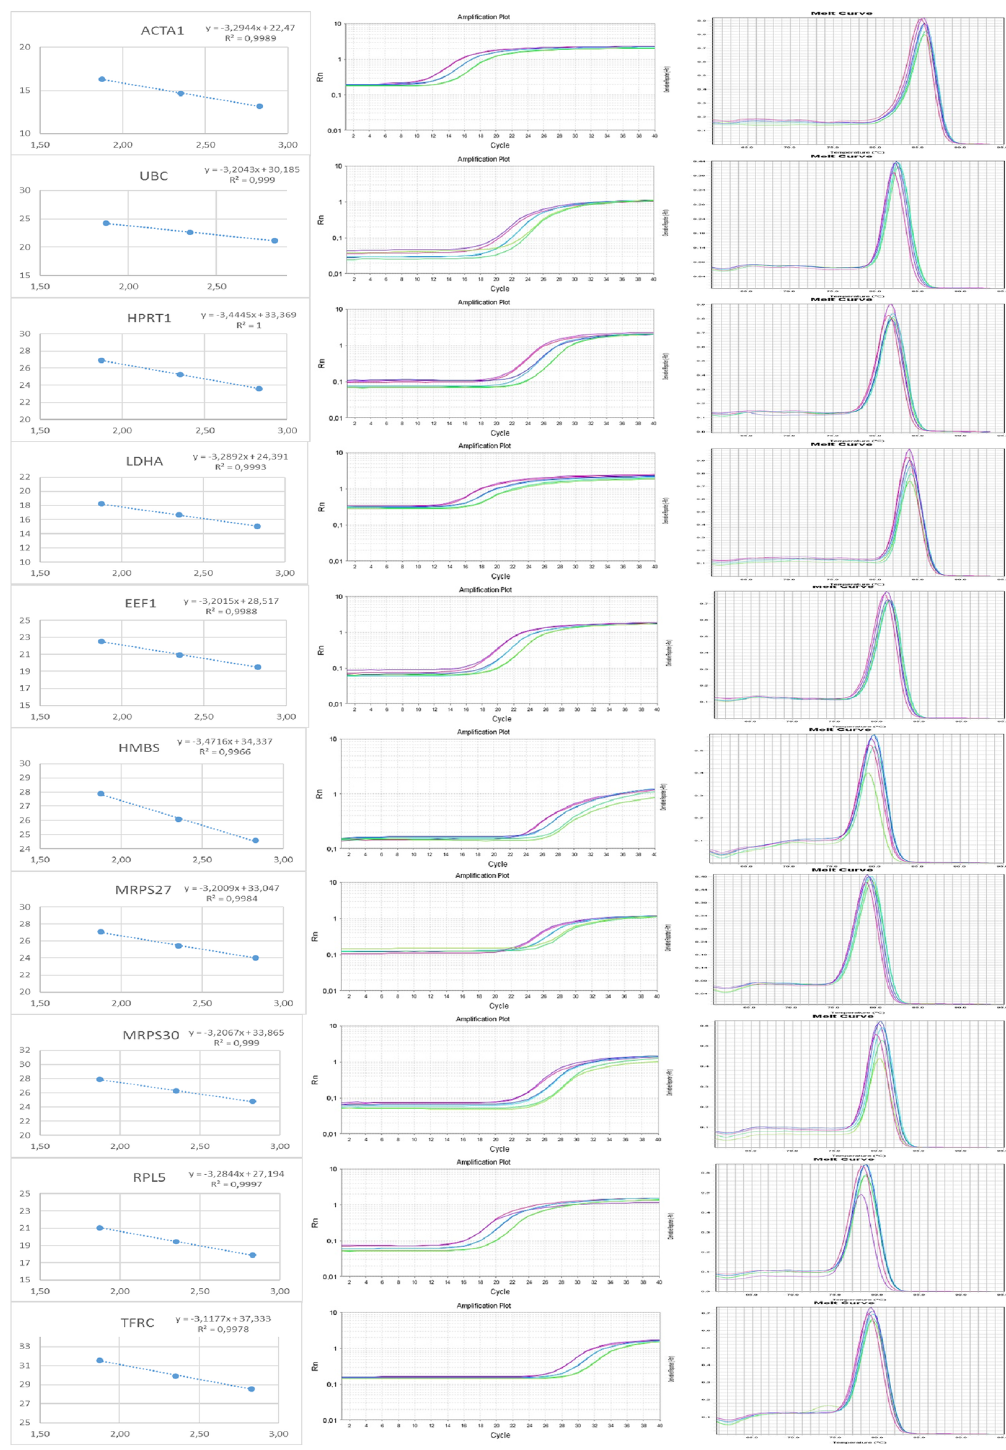
Fig 1. Curvesof regression, amplification and dissociation from efficiency test of 10 referencegenes of chicken in RT-qPCR reactions. All dissociationcurves showedonly one peak.